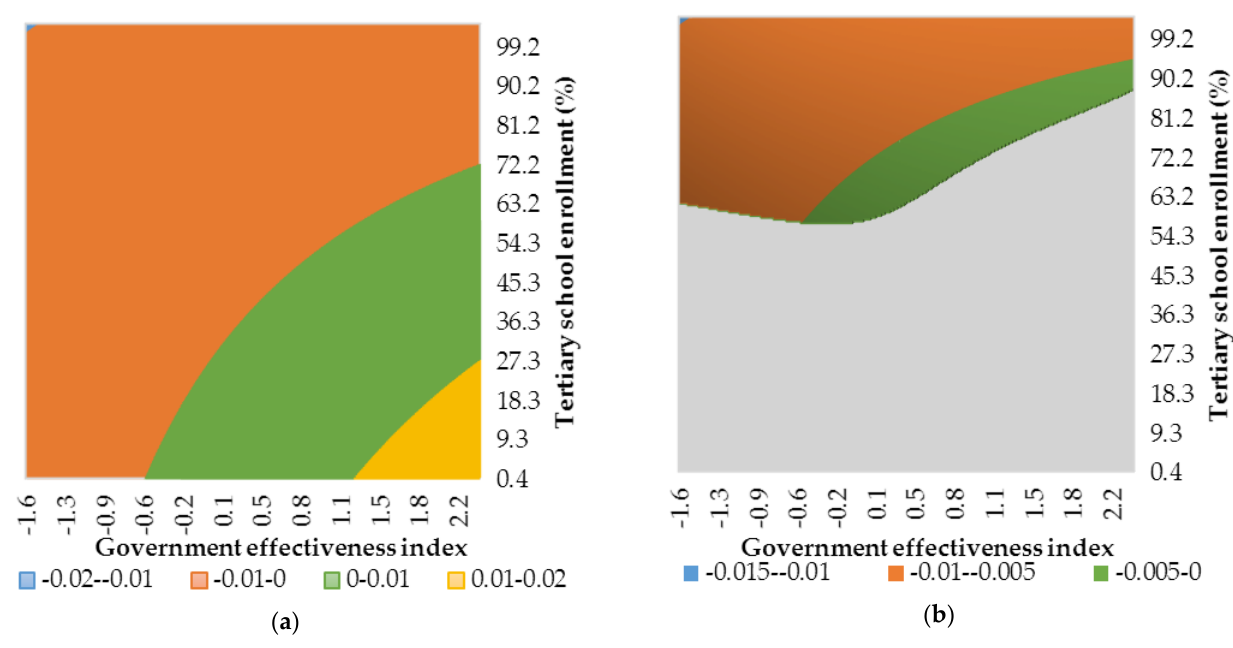
Figure A8. Conditional effect of financialisation on growth based on Est. 8 in Table A2. ( a ) Estimated conditional slope coefficient over the whole range of observed values for institutional quality and development level. ( b ) Estimated statistically significant conditional slope coefficient. Gray represents a combination of institutional quality and development level for which effect of financialisation on growth is statistically insignificant. Source: authors’ contributions.